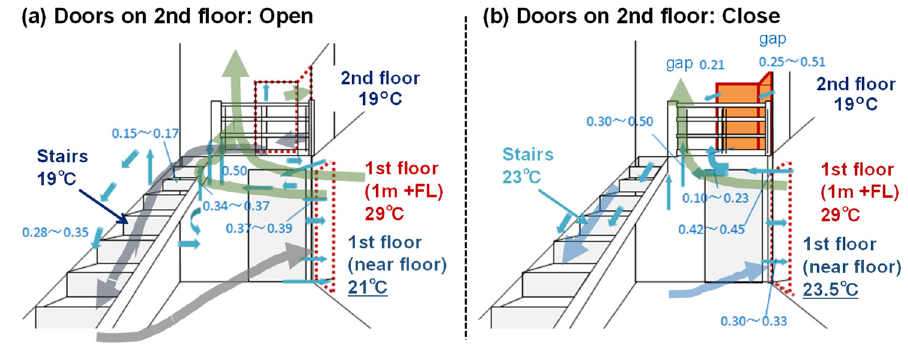
Figure 12. Air velocity and temperature in the staircase; ( a ) opened and ( b ) closed cases. decreased, returning to the Zashiki at 0.3–0.33 m/s and 23.5 ◦ C, and the draft in the Zashiki was weakened.